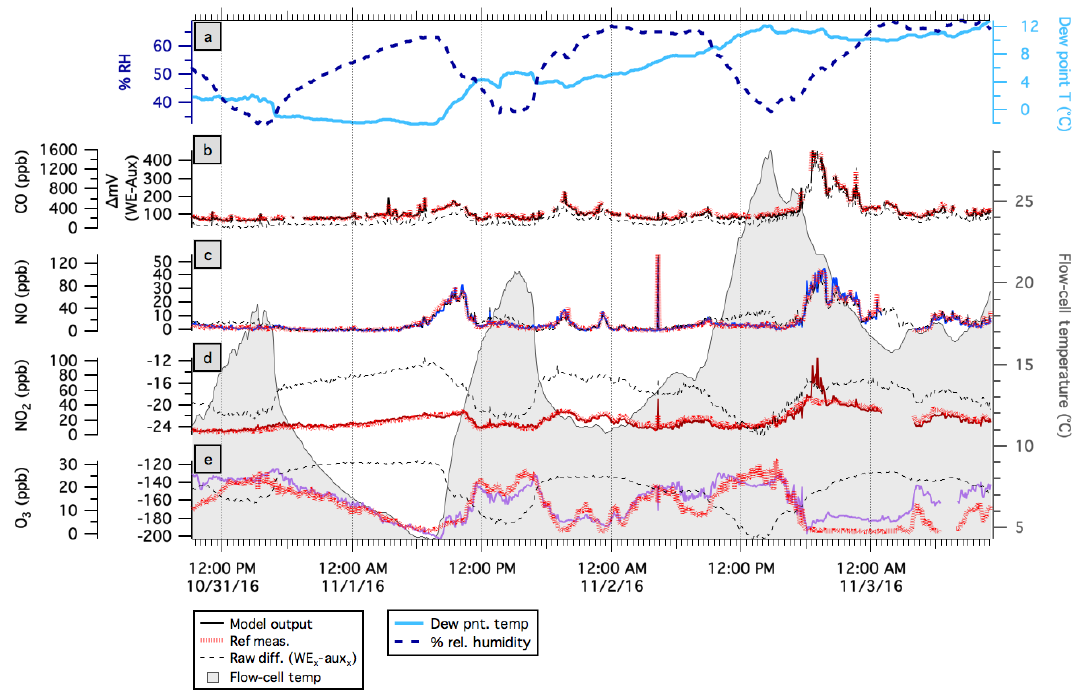
Figure 3. (a) Relative humidity (dashed blue line) and dew point temperature (solid blue line), (b–e) raw differential sensor output (dashed line), reference measurement (thick red line), and model output (thin line) for a 3-day period during the test part of the 4.5-month deployment. Temperature is indicated with the grey shaded